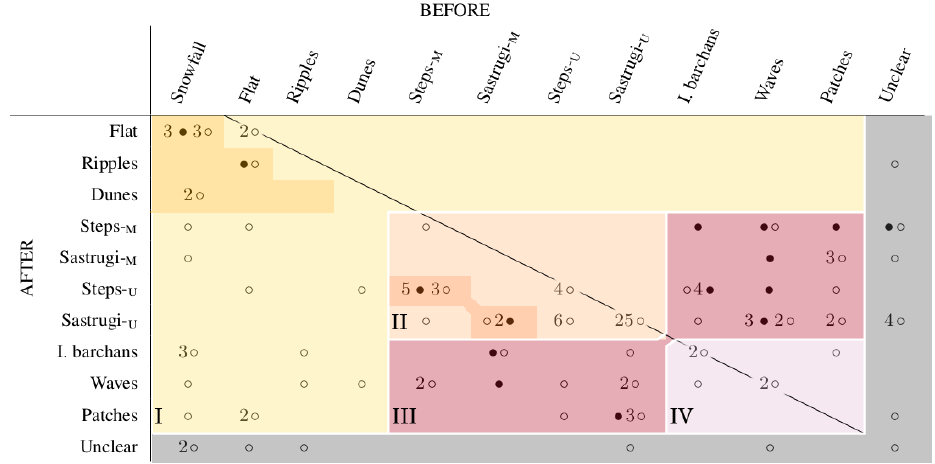
Figure 11. Transitions from one type of bedform to another, either observed directly ( • ) or implied during a < 12h gap in footage ( ◦ , e.g., overnight). Snow steps and sastrugi may be moving (M) or unmoving (U) when observed. “Dunes” are close-packed (as in Fig. 2b), and “I barchans” are separated (as in Fig. 2d).